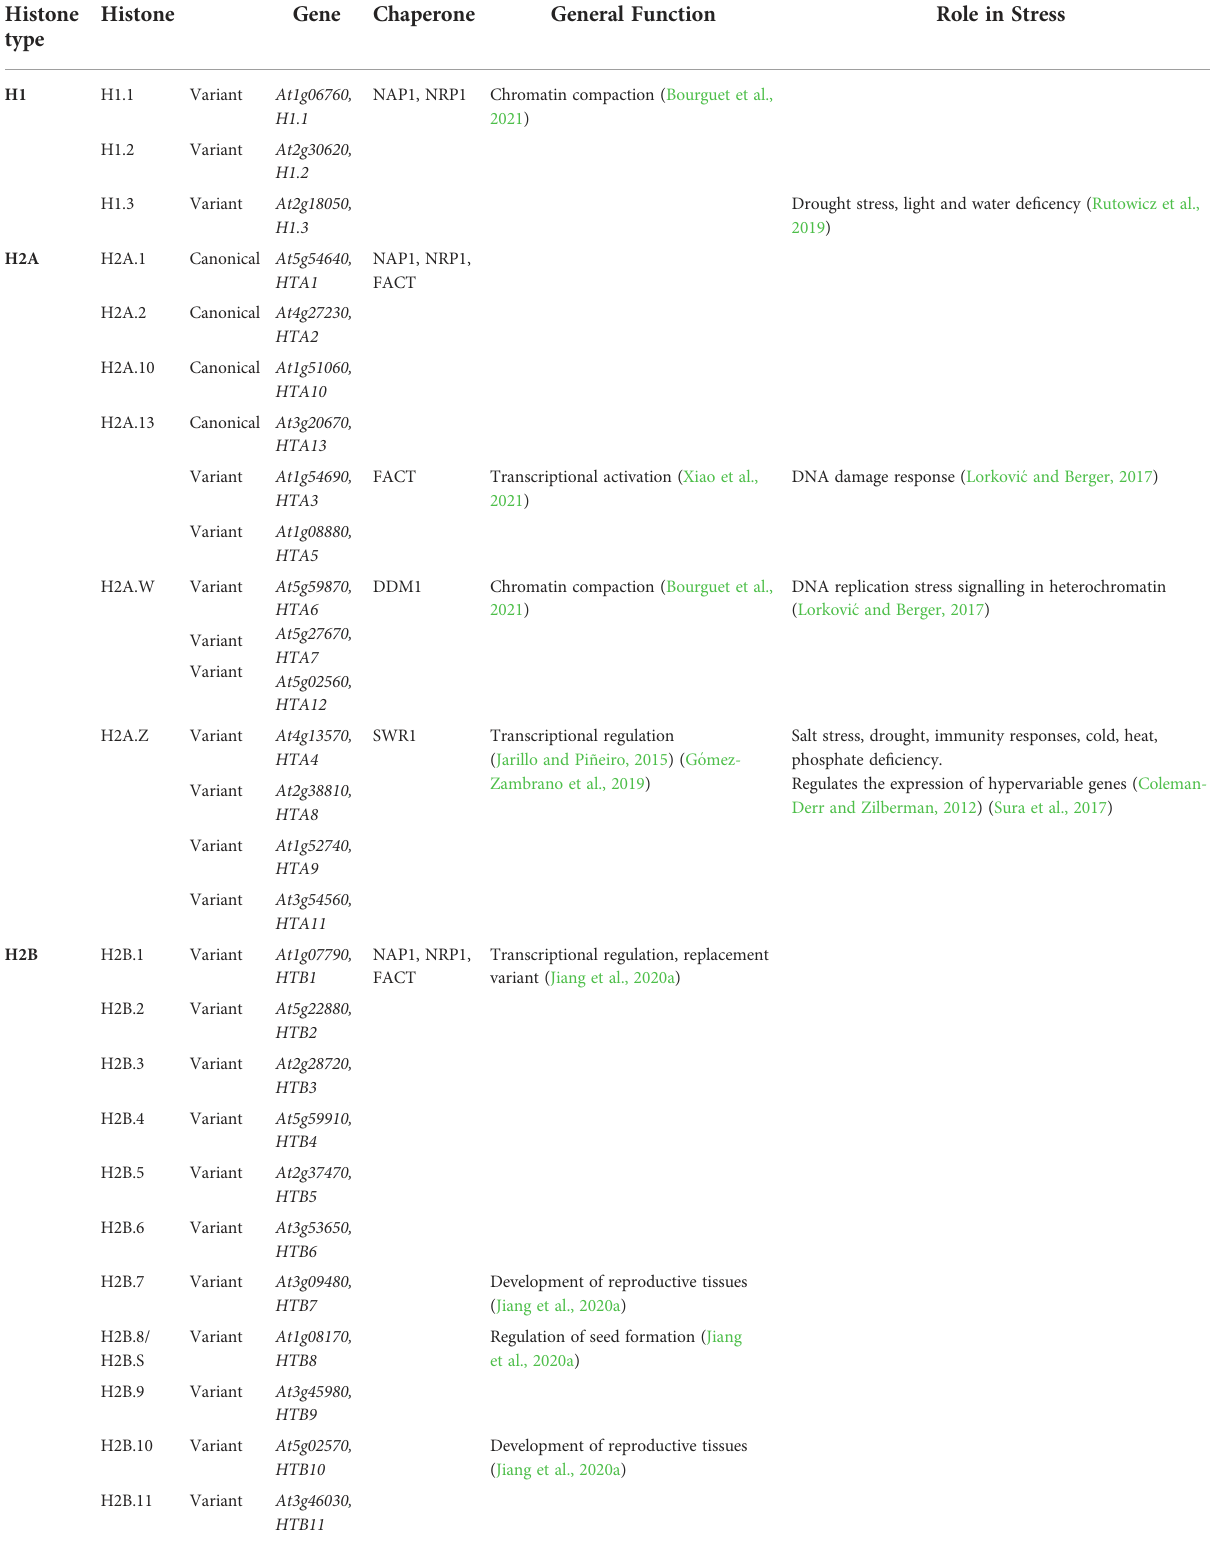
TABLE 1 Classi fi cation of histone families in Arabidopsis : genes, variants, proteins, chaperones, general function and role in stress. Histone